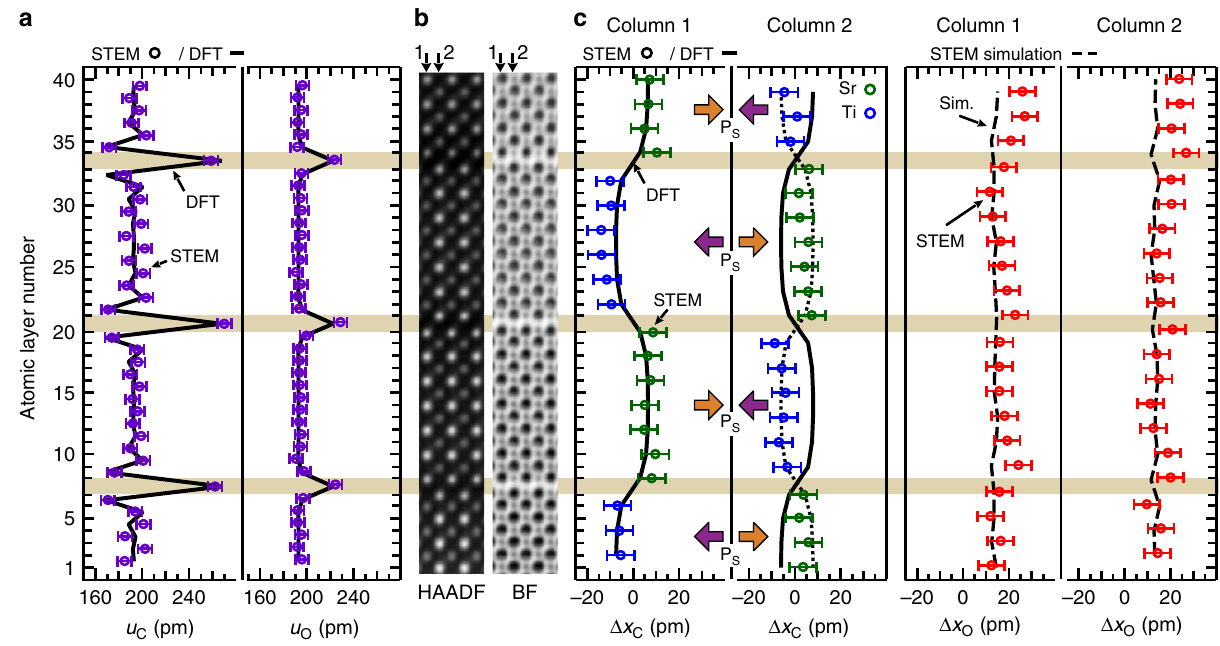
Figure 4 | Unknown AFE-like atomic columns in Sr 7 Ti 6 O 19 film region #2. ( a ) Cation u C and oxygen u O interatomic spacing (purple open circles) extracted from constructed drift-corrected HAADF and BF STEM images superimposed on the DFT calculated values (black lines). The characteristic decrease in interplanar spacing in u C and absence in u O adjacent to the rock salt layers indicates the presence of rumpling at the rock salt layer; exceptional agreement between experiments and DFT is seen. ( b ) Constructed average HAADF and BF STEM slices, which are repeated for clarity. ( c ) Cation D x C (blue and green open circles) and oxygen D x O (red open circles) displacements along the [100] PC direction measured from the drift-corrected HAADF and BF images. The AFE DFTcalculated value (solid black lines) and the AFE STEM simulated D x O values (dashed light blue line) are superimposed to show agreement between simulation and experiments. Included in column 2 is the p phase shifted cation positions (dotted black line) for comparison with the STEM data. The simulated D x O values (dashed black lines) were done with a 1.25mrad sample tilt around the [001] PC axis. The error bars are taken to be the root mean s.e. from the positions of a best fit lattice determined by